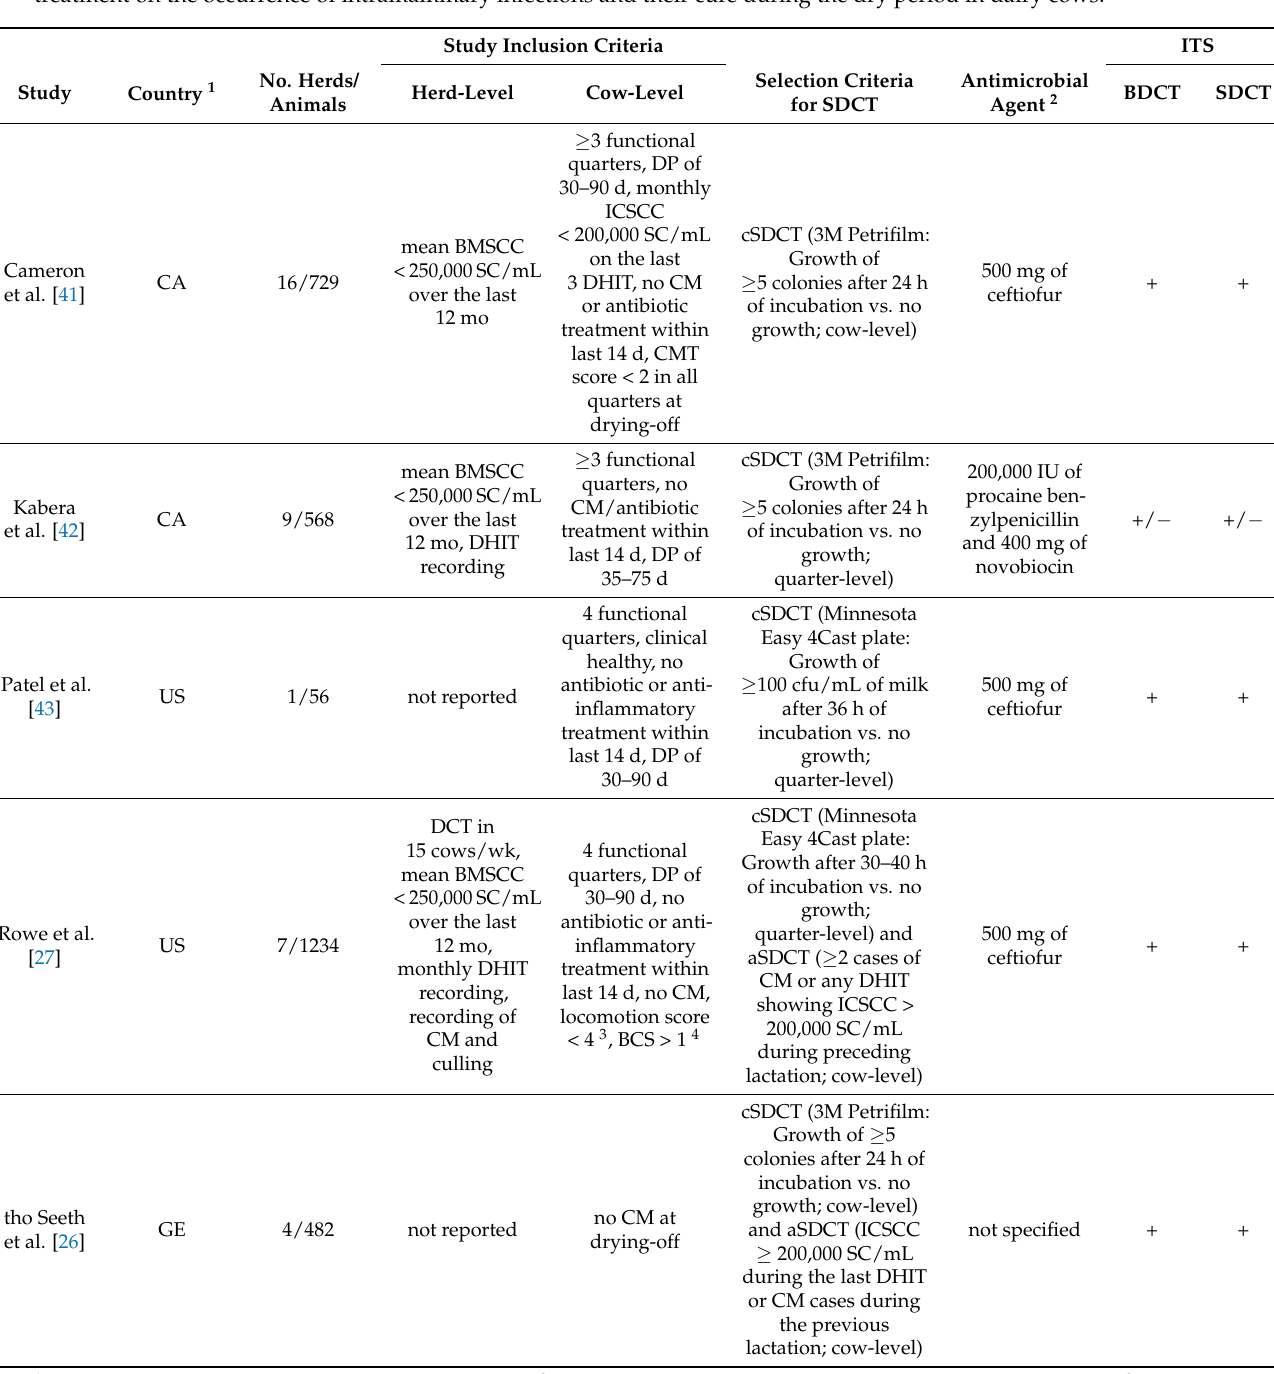
Table 1. Characteristics of manuscripts included in the meta-analysis evaluating the effect of selective vs. blanket dry cow treatment on the occurrence of intramammary infections and their cure during the dry period in dairy